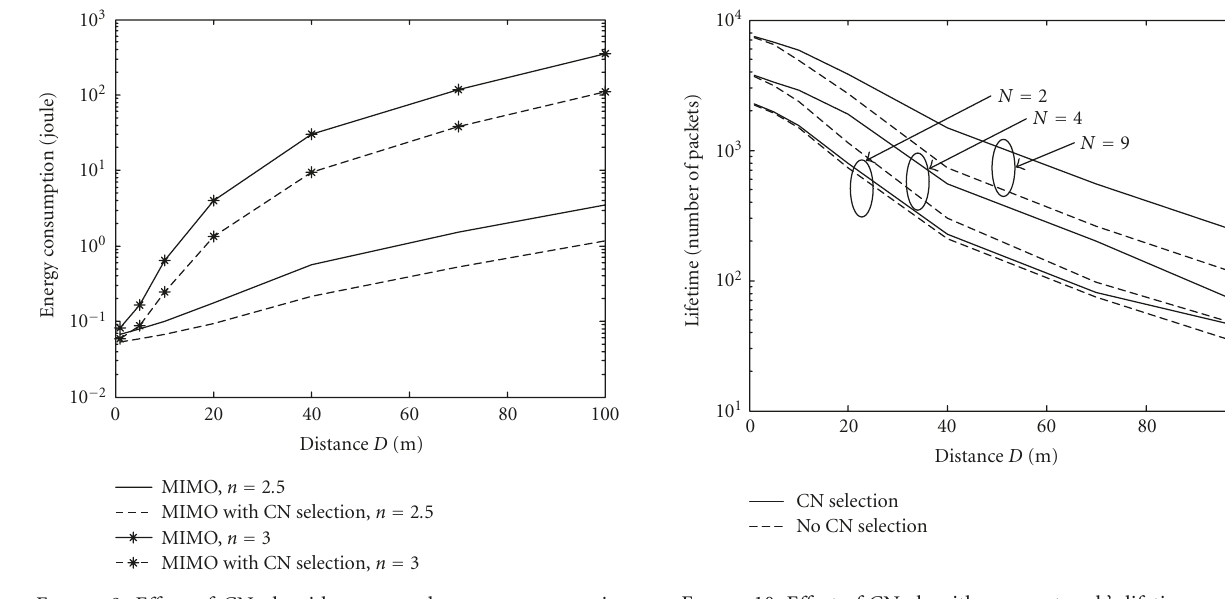
Figure 9: E ff ect of CN algorithm on total energy consumption, M = 100.